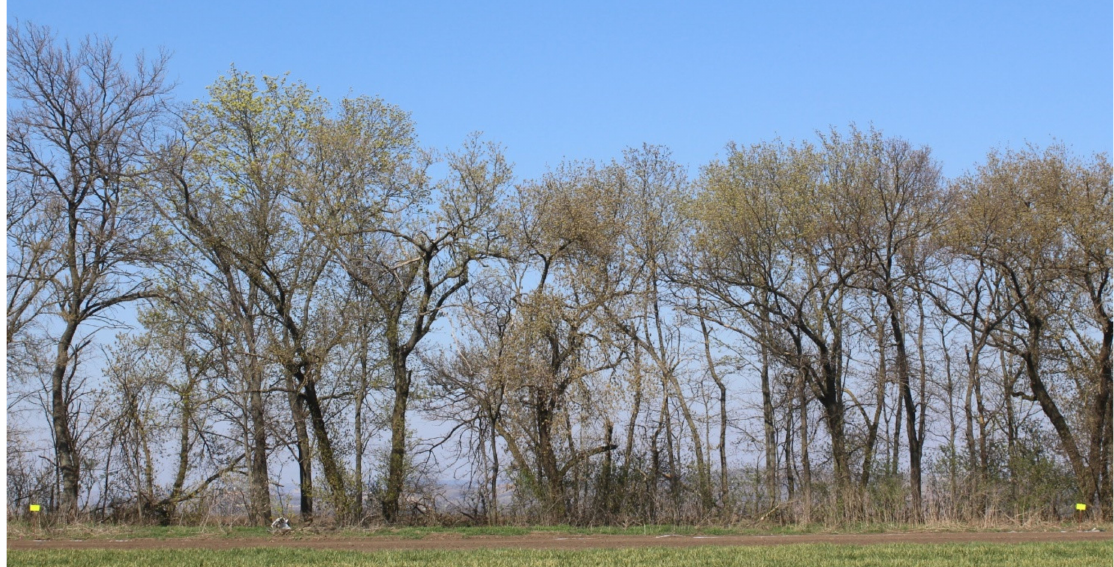
Figure 8. Study locality Bulhary-windbreak 1.